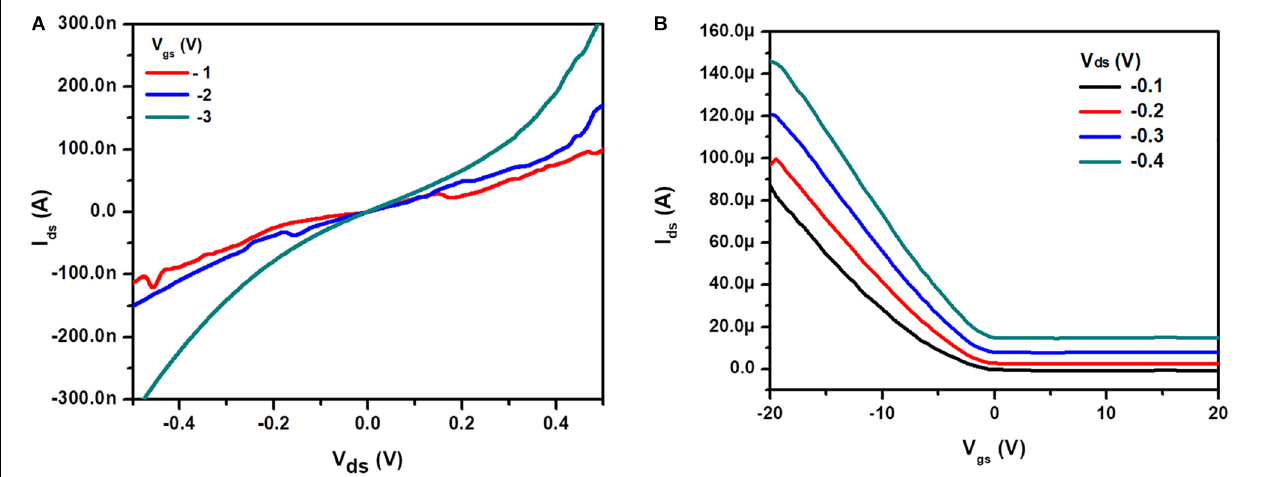
FIGURE 7 | FET measurements of Ni 3 BTC 2 /OH-SWNTs composite material (A) Output and (B) Transfer characteristics.